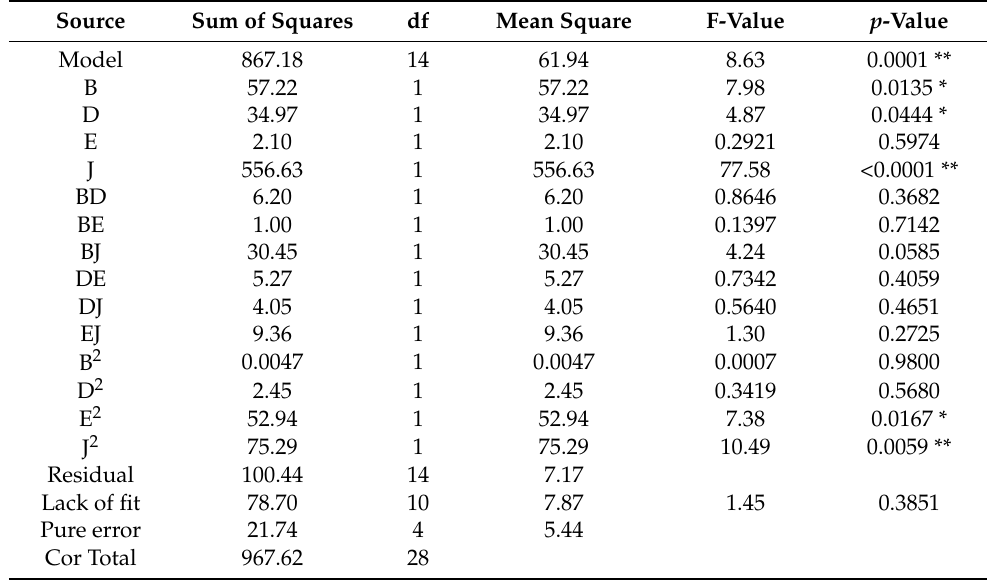
Table 6. ANOVA of the quadratic model for